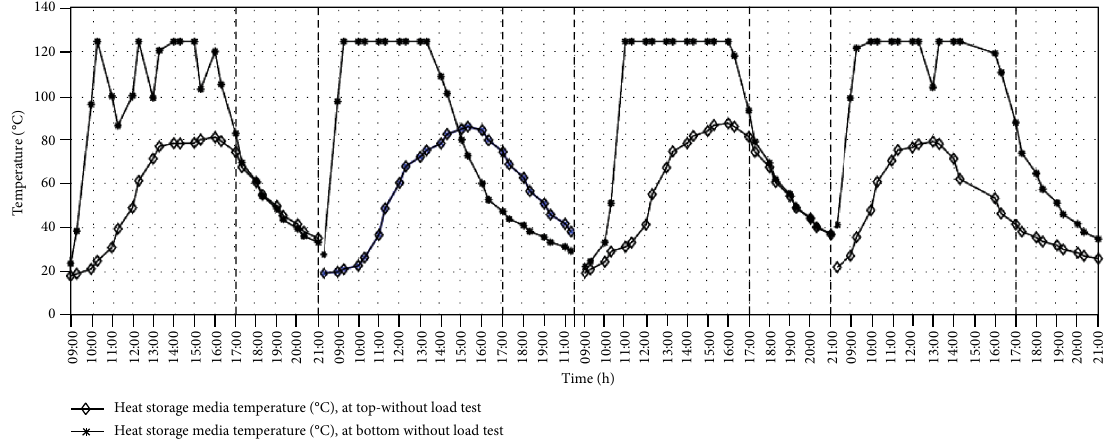
Figure 9: Variance of heat storage medium temperature without load tests at the top and bottom side with time.